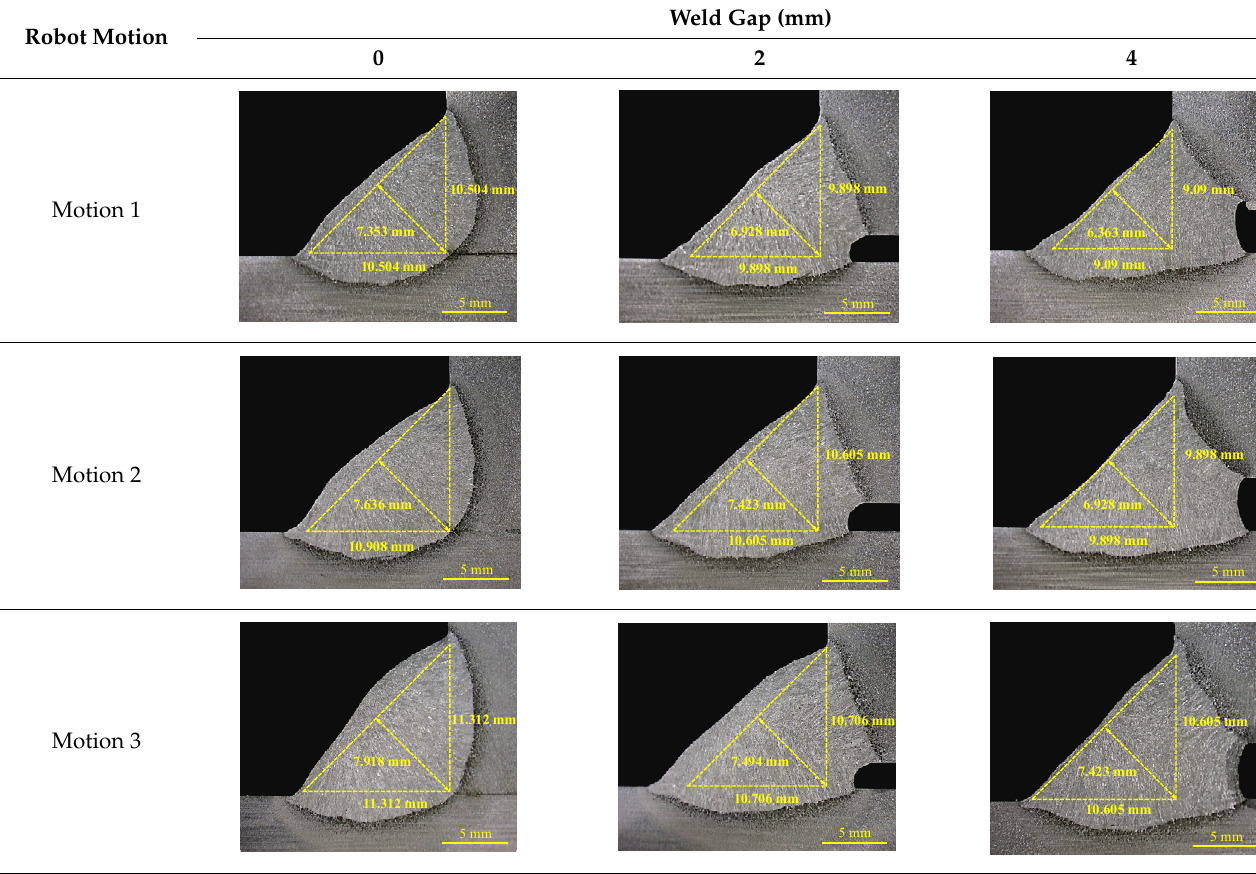
Table 3. Weld bead cross-sectional analysis.